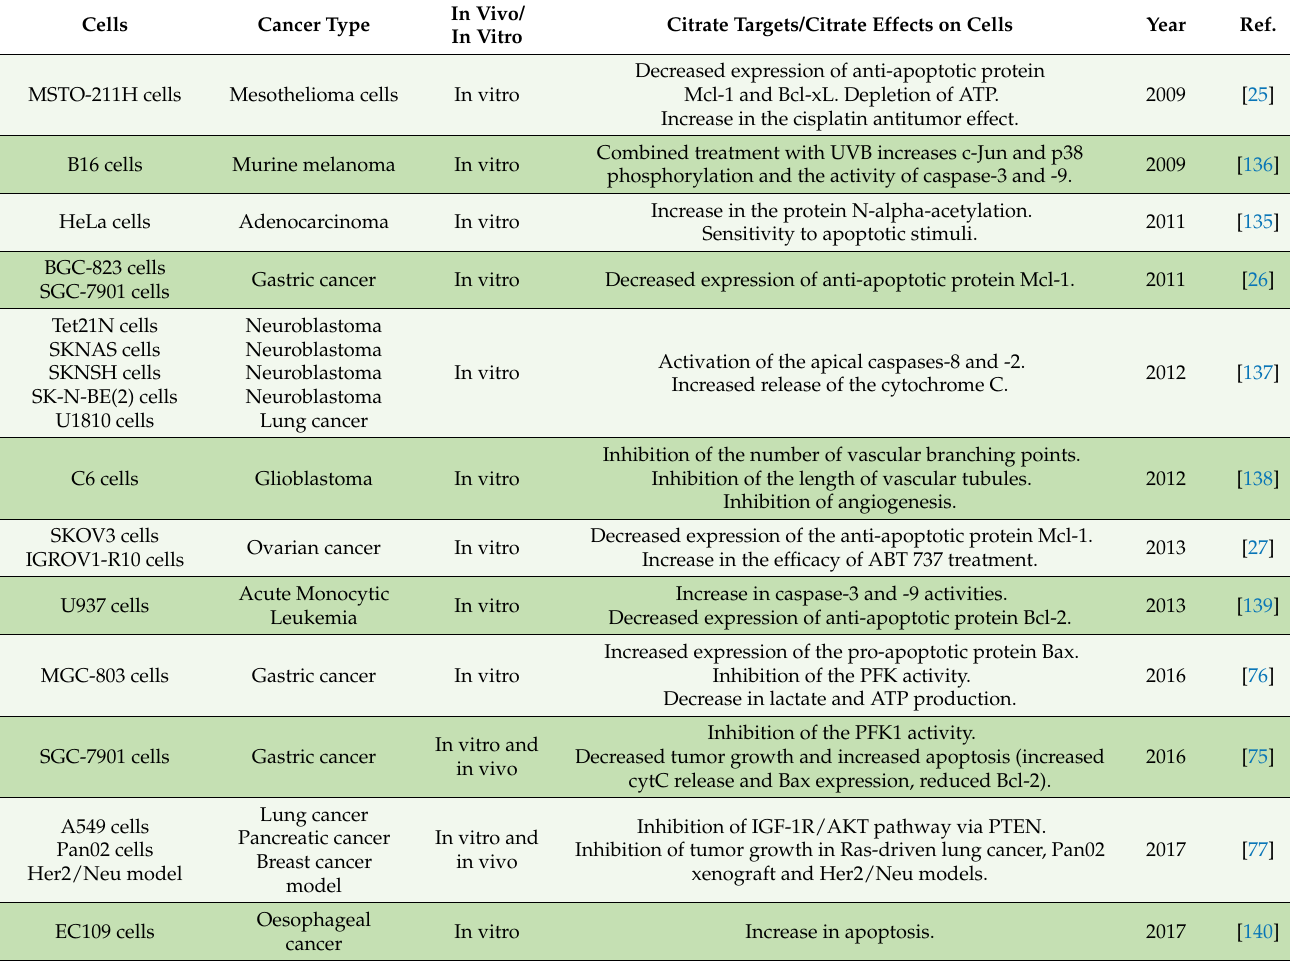
Table 1. Literature review of the main studies describing the effects of citrate ( ≥ 10 mM) on cancer cells. In Vivo/ Citrate Targets/Citrate Effects on Cells Year Cells Cancer Type In Vitro